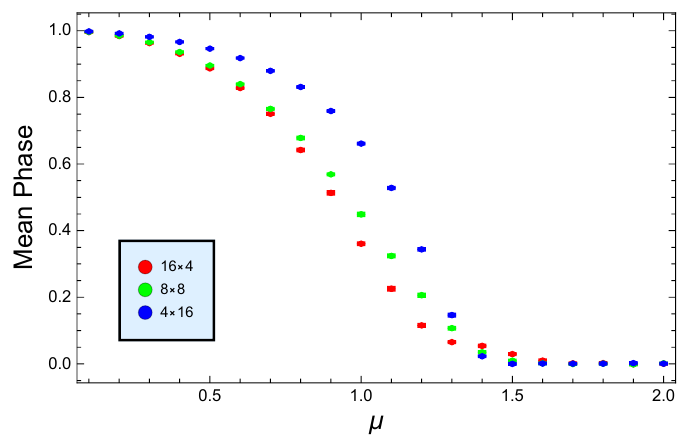
Figure 9 . The mean phase factor as a function of µ for different geometries with 64 lattice points in two dimensions for m = 1 . Different geometries are identified as L × ˜ L . We note that while the L = 4 case behaves better than the other two cases (for small µ ) the difference between the cases with L = 8 and L = 16 is not very strong. Around µ = 1 . 4 the contribution of the effect of the boundary becomes more significant than that of the effect of the short temporal direction. From this point on small values of ˜ L instead of small values of L are associated with better behaviour of the mean phase